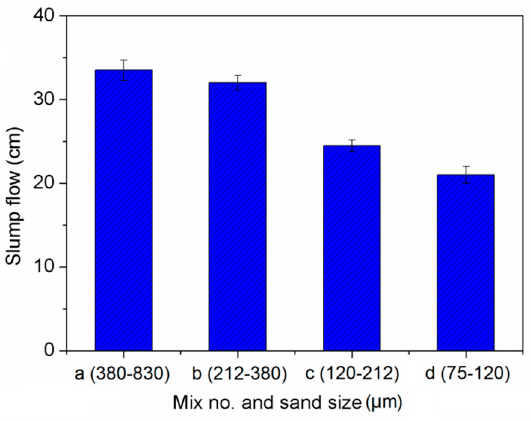
Figure 5. Slump flow of cement-based Figure 5 . Slump flow of cement-based composites.